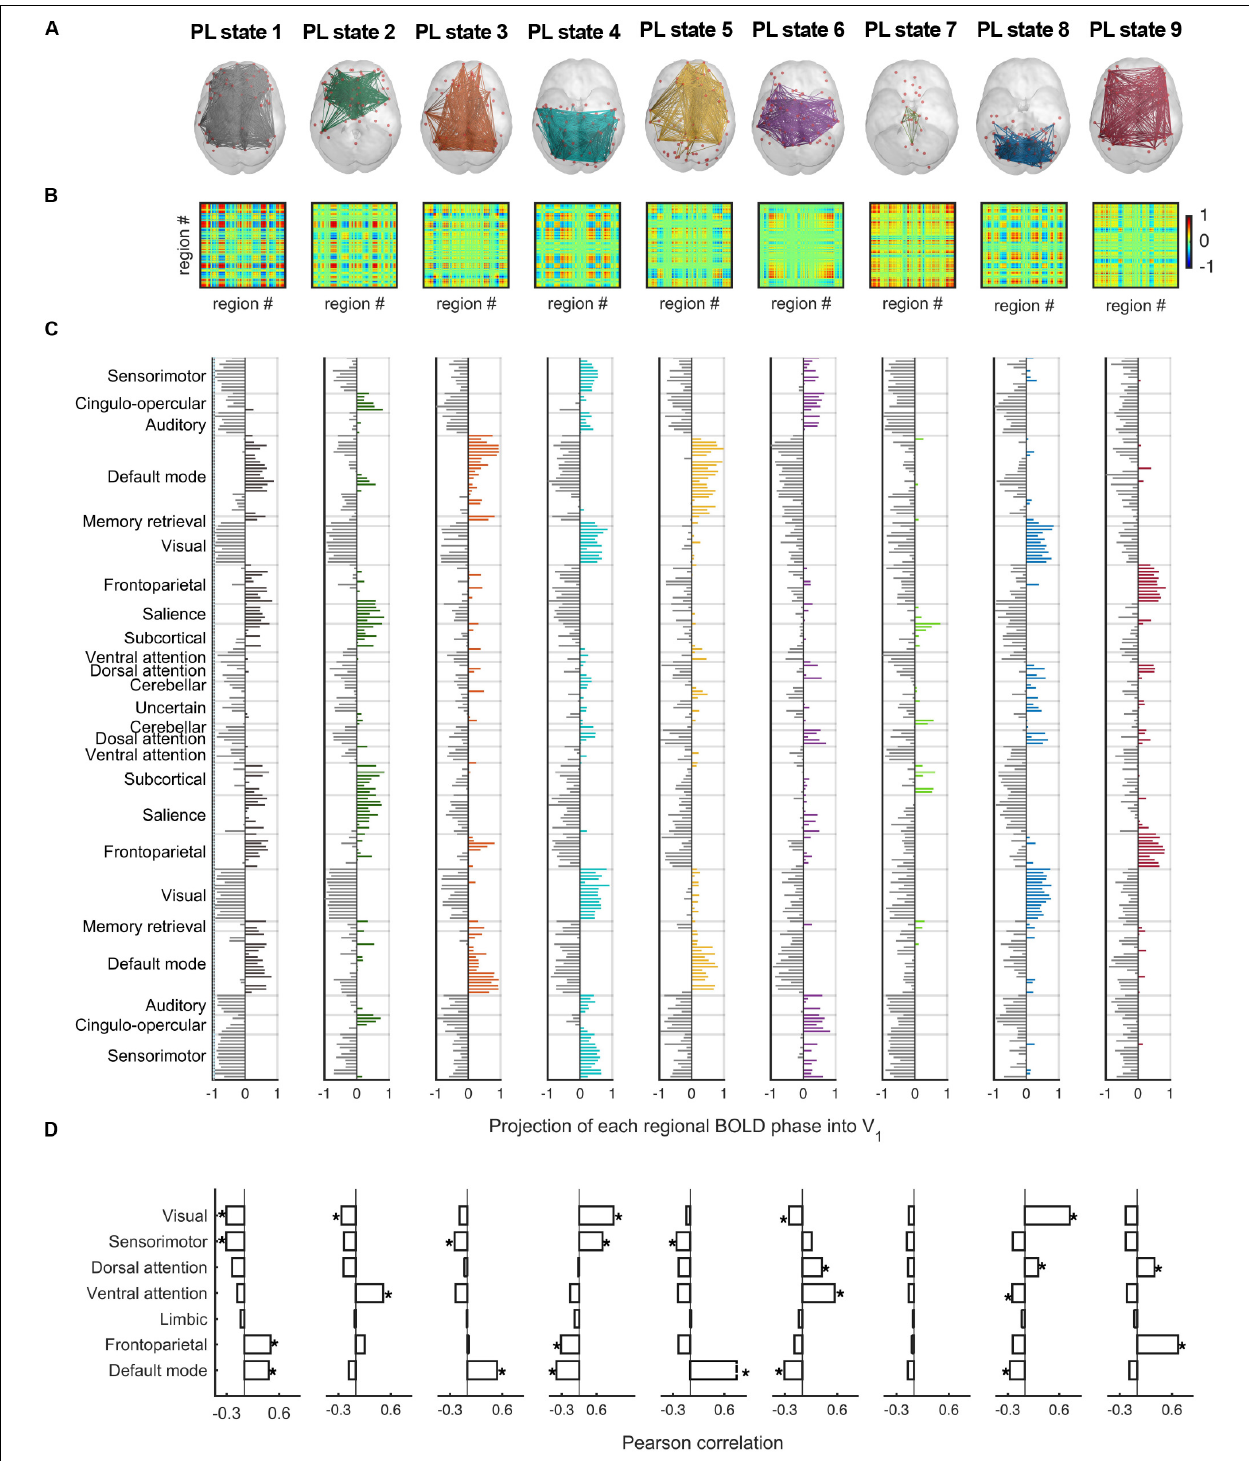
Frontiers in Neural Circuits |